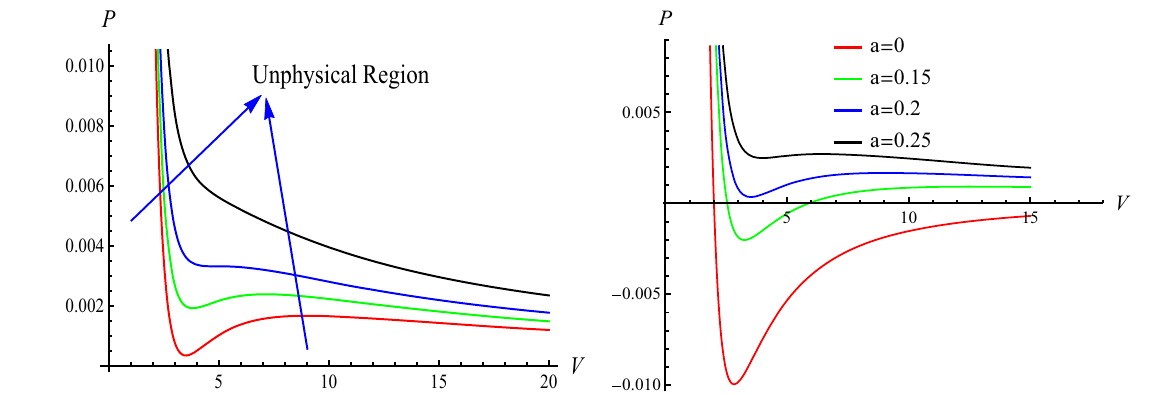
Fig. 8 For the left plot , the left region and the bottom area of the red isotherm , which represents T = 0, corresponds to negative temperature isothermswhichareunphysical.Inthe rightplot ,weplotfourisotherms with temperature T = 0, and we see that the isotherms will move to the right with the increase of the parameter a , i.e. the unphysical region